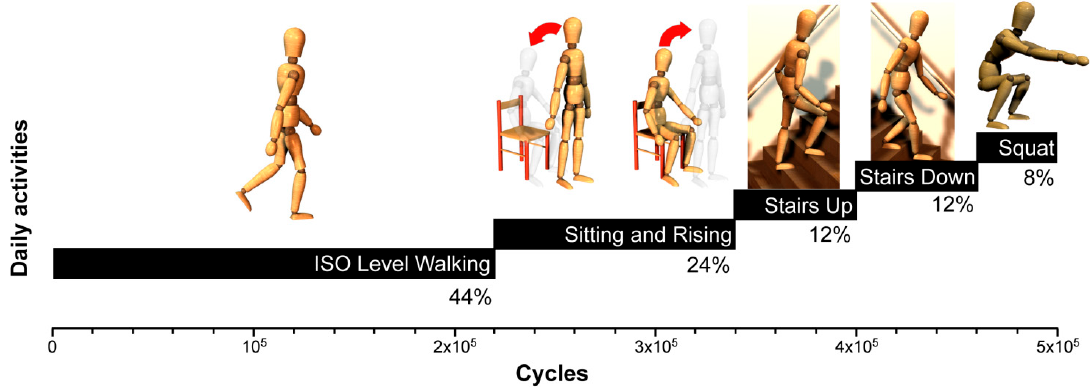
Figure 1. Distribution of high-demand daily activities during wear test.